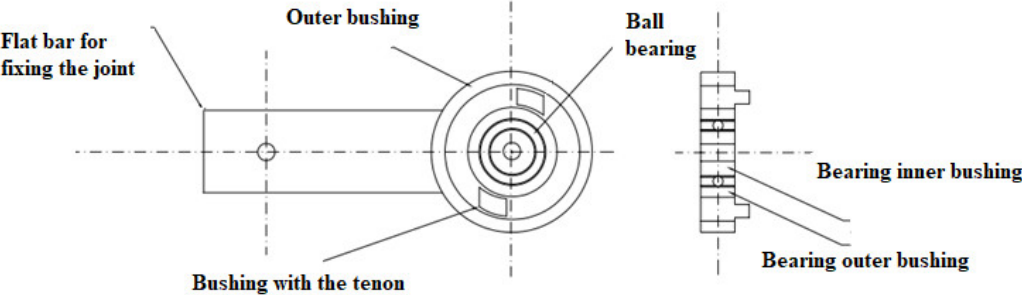
Figure 10. View right parts of the elbow joint of the anthropometric crash test dummy.